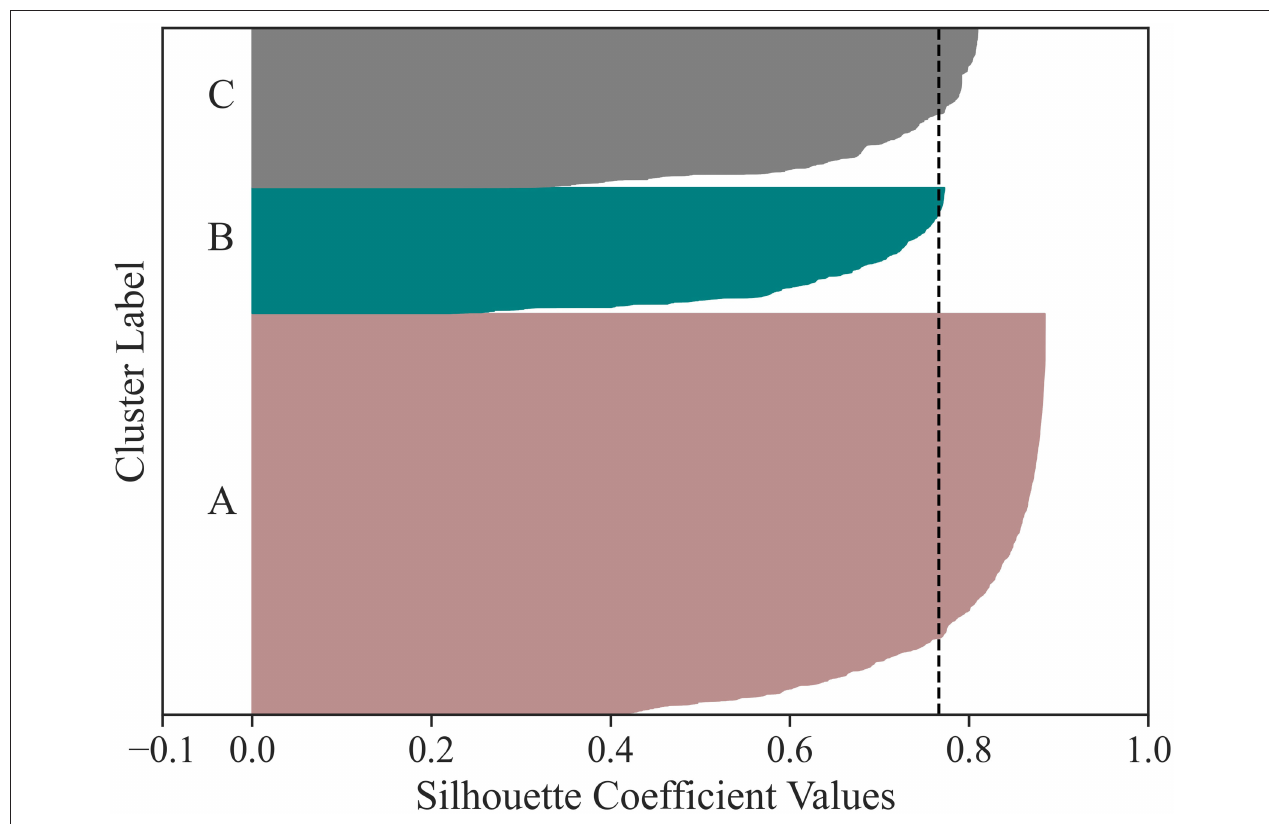
FIGURE 6 | The Silhouette coefficient value of each observation is displayed for the three user clusters (i.e., for each cluster, the observations are ordered by their Silhouette coefficient value and displayed in ascending order as horizontal stacked lines). The average silhouette score is reported (dashed line). The three clusters have predominantly positive and large scores, suggesting valid